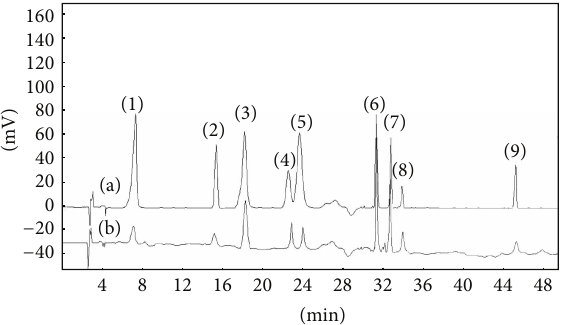
Figure 2: HPLC chromatograms. (a) HPLC chromatograms of a standard solution ( (1) gallic acid = 20 𝜇 g/mL, (2) catechin = 20 𝜇 g/mL, (3) p-hydroxybenzoic acid = 20 𝜇 g/mL, (4) vanillic acid = 22 𝜇 g/mL, (5) caffeic acid = 20 𝜇 g/mL, (6) ferulaic acid = 19 𝜇 g/mL, (7) rutin = 20 𝜇 g/mL, (8) benzoic acid = 25 𝜇 g/mL, (9) quercetin = 10 𝜇 g/mL). (b) Typical HPLC chromatogram obtained by direct injection of 20 𝜇 L of extract of polyphenols from Epimedium bre- vicornum Maxim by optimized conditions (ethanol concentration 50%, extraction time 27.5 min, and ratio of aqueous ethanol to raw material 250 mL/g).